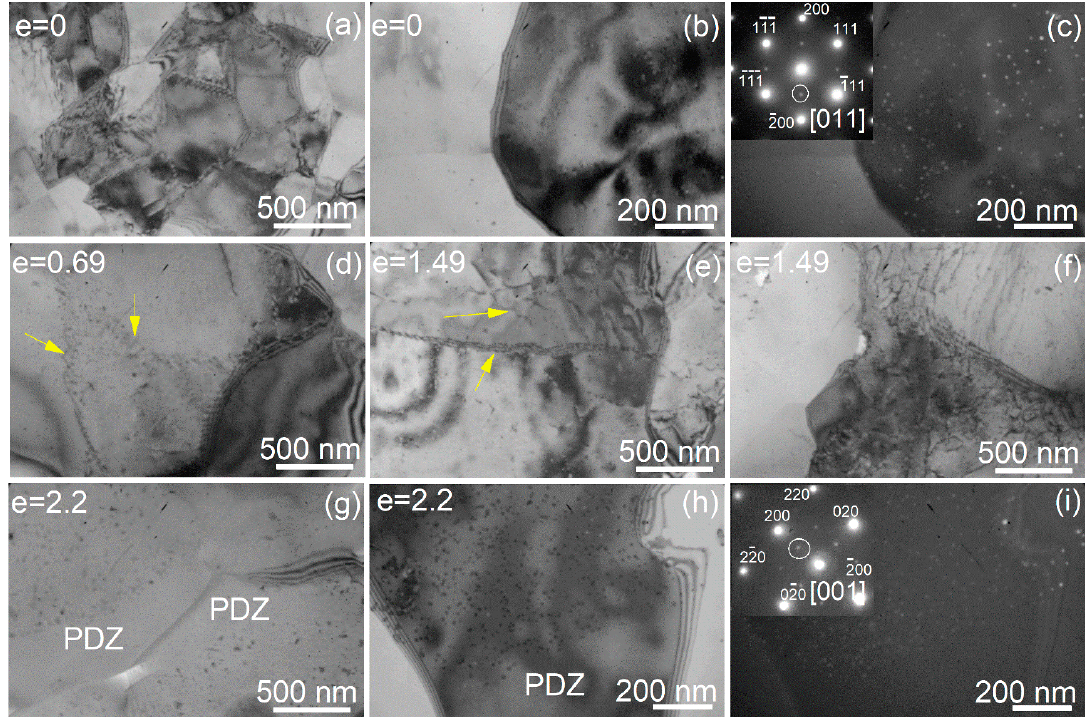
Figure 5. TEM structures after 20 min of annealing at 440 °C ( a – с ), after strain 0.69 ( d ), 1.49 ( e , f ), and 2.2 ( g – i ) at a temperature of 440 °C and a strain rate of 0.02 s − 1 ; the yellow arrows show the dislocation walls.